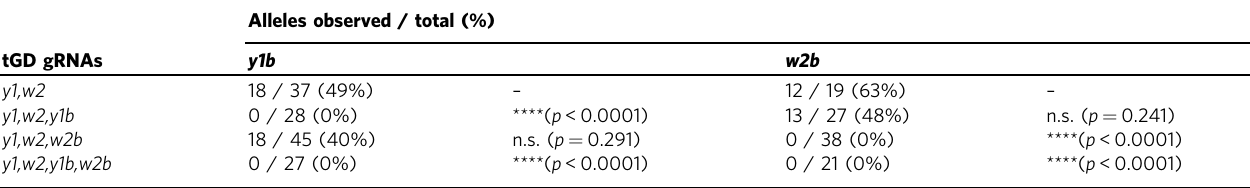
Table 1 Summary of the indel sequence